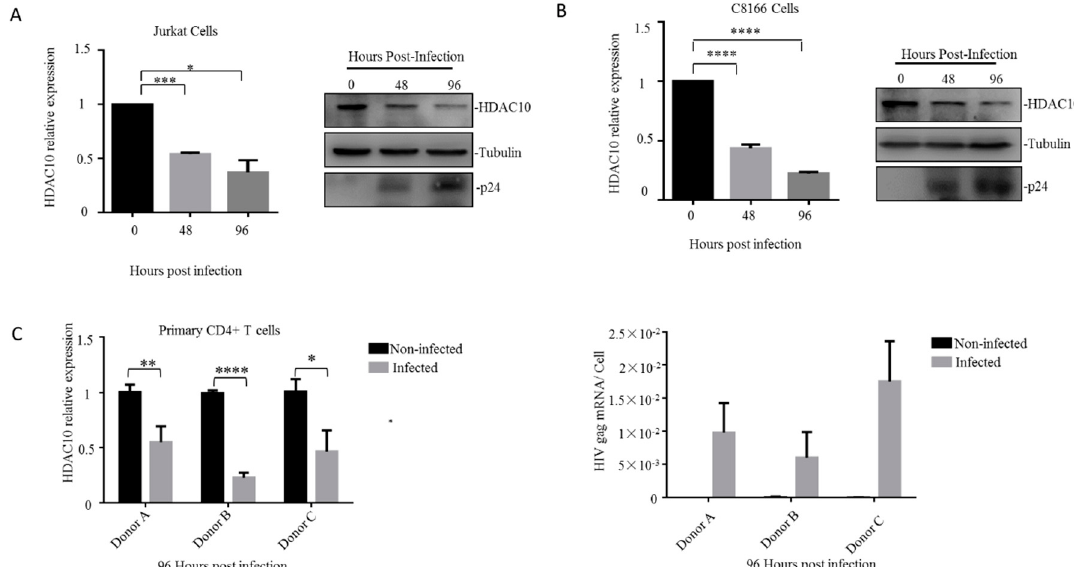
Figure 1. HDAC10 is downregulated in CD4 + T cells during HIV-1 infection. ( A , B ) The HDAC10 mRNA (left panel) and protein (right panel) expression changes during HIV-1 infection in Jurkat cells ( A ) or C8166 cells ( B ). Jurkat cells or C8166 cells were infected with HIV-1 (N119) and collected at 0, 48, and 96 h. The HDAC10 mRNA was detected by quantitative RT-PCR and normalized by house-keeping gene GAPDH while the HDAC10, tubulin, and HIV-1p24 proteins were detected by WB. ( C ) Primary CD4 + T cells isolated from three healthy individuals were infected with HIV-1 (N119) and collected after 96 h of infection. The endogenous HDAC10 mRNA (upper panel) was monitored by quantitative RT-PCR. HIV-1gag mRNA (lower panel) levels were detected by real-time RT-PCR and normalized by cell counts. Data are mean and sd (standard deviation). *, p < 0.05; **, p < 0.01, ***, p < 0.005; ****, p < 0.001. (Two-tailed unpaired t